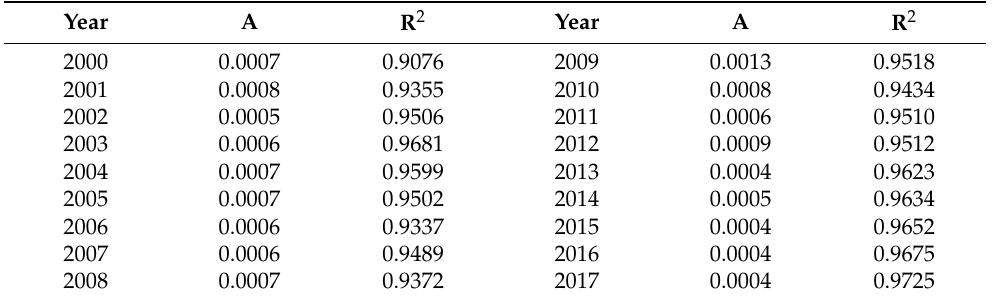
Table 3. Linear regression model of urban CO 2 emission statistics and nighttime light gray